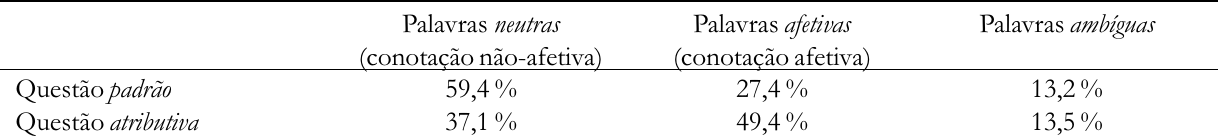
Efeito da Ativa(cid:231)ªo (cid:147)Afetiva(cid:148), Objeto (cid:147)Fam(cid:237)lia(cid:148)